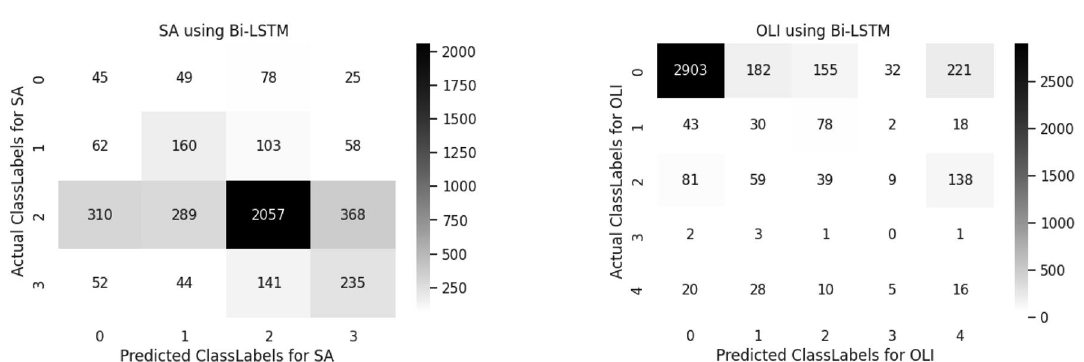
Figure 5. Confusion matrix of CNN for sentiment analysis and offensive language identification.